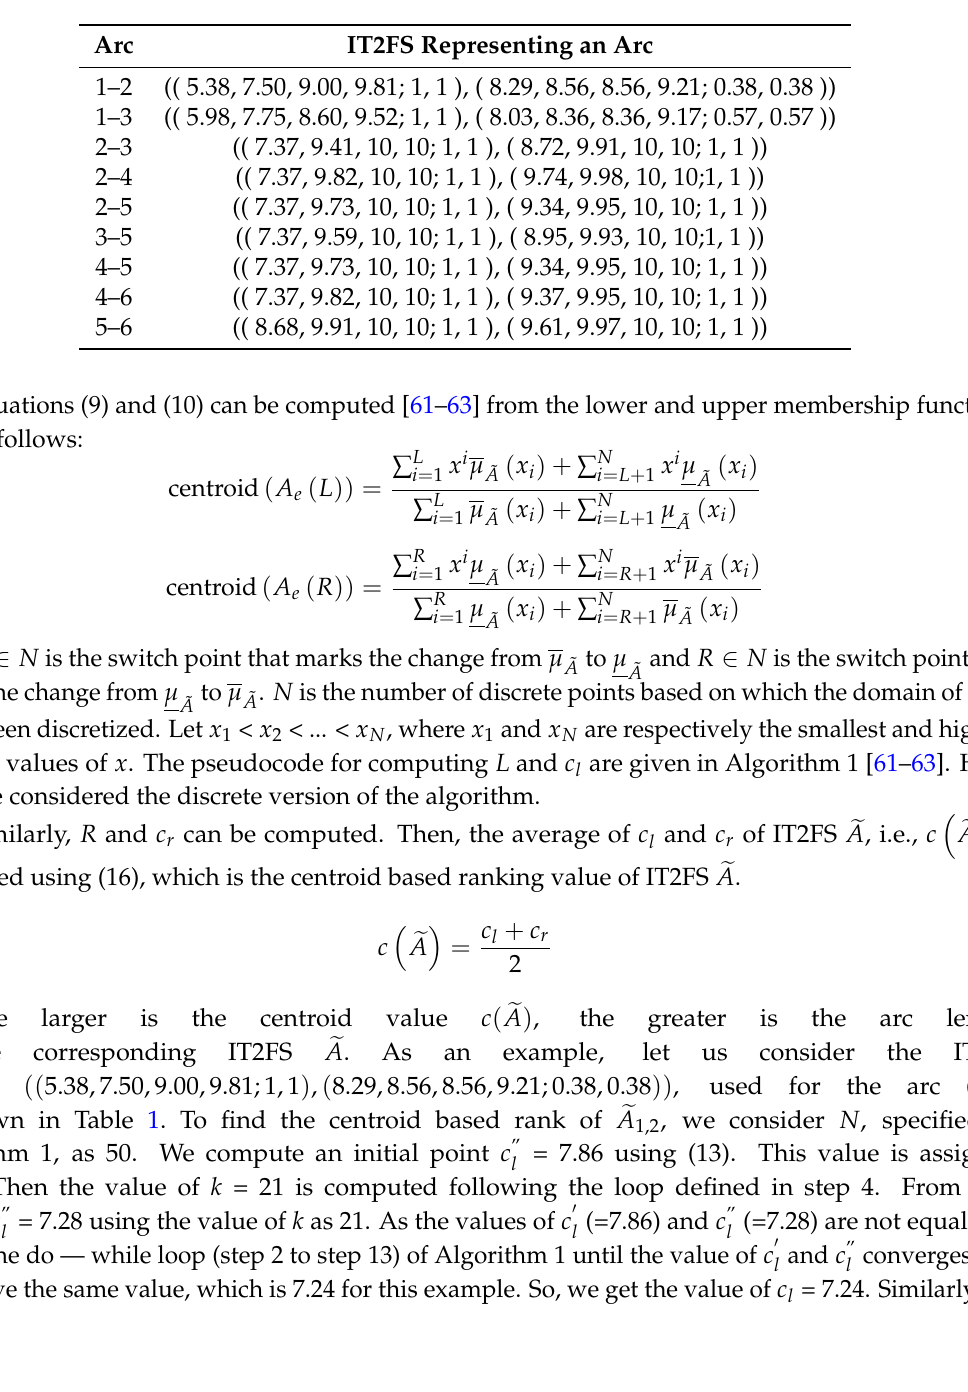
Table 1. The arcs of the fuzzy graph, shown in Figure